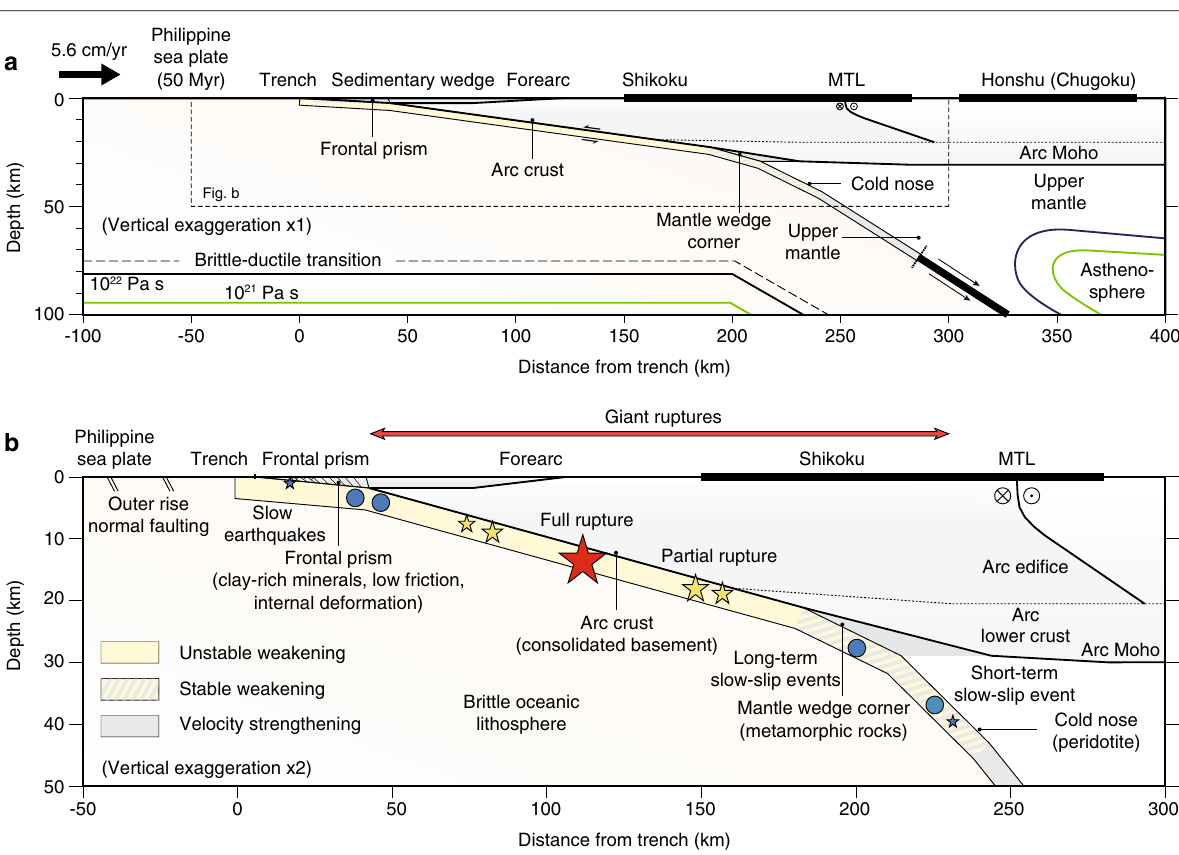
Fig. 11 Conceptual rheological model of the Nankai subduction zone. a The down-going Philippine Sea Plate intersects different domains of the overriding plate, which controls the subduction dynamics including seismic cycles and the asthenosphere flow. b The full spectrum of simulated slip modes including full and partial ruptures, slow earthquakes and slow-slip events are distributed within down-dip segments along the megathrust fault. The interaction between neighboring segments leads to additional complexity, including triggered slow slip and slow earthquakes, and aperiodic recurrence patterns of earthquakes and slow-slip